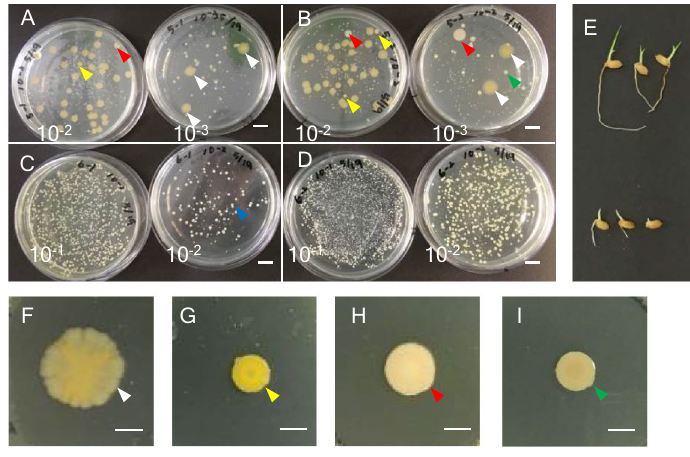
Figure 2. Diverse bacterial population in pregerminated seedlings and identified RSBs. Pregerminated and non-pregerminated rice seeds were inoculated with B. glumae 301682 (OD = 0.0004) under reduced pressure. ( A – D ) The bacterial population at 4 dpi. A lysate from whole seedlings was plated on an LB plate supplemented with Chloramphenicol at the indicated dilutions. Two independent sets ( A , B for pregerminated, C , D for non-pregerminated) of the experiments are shown. Bars, 1 cm ( E ) Photographs of the 4 dpi seedlings. Top panel shows pregerminated, bottom panel shows non-pregerminated. ( F – I ) Colonies of rice seed-born (RSB) microbes isolated from pregerminated seedlings. Bars, 1 mm Photographs are taken after 5 d on NA medium. White arrow shows RSB1, yellow is RSB10, red is RSB15, green is RSB2 and blue is B. glumae on ( A , B , F , G , H , I ). Results are representative of two